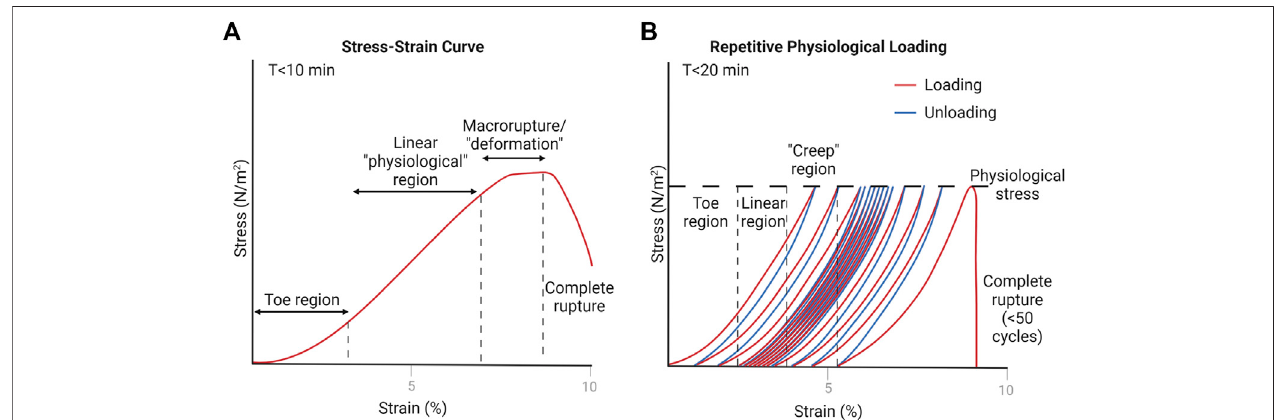
FIGURE 4 | Representative estimations of tendon loading schemes. Created with Biorender.com. (A) Pull-to-failure test results in a stress-strain curve when normalized to tendon cross-sectional area (Wang, 2006; Wang et al., 2012). The toe region is due to natural collagen fi ber crimping, the linear region is equated to physiological stress values, and the deformation region is where macro-scale ruptures start to occur (Louis-Ugbo et al., 2004). (B) Fatigue test indicates similar regions that occur due to repetitive physiological loading, where “ creep ” occurs due to macro-scale ruptures eventually leading to complete rupture of the tendon after a number of cycles (usually less than 50) (Thornton et al.,